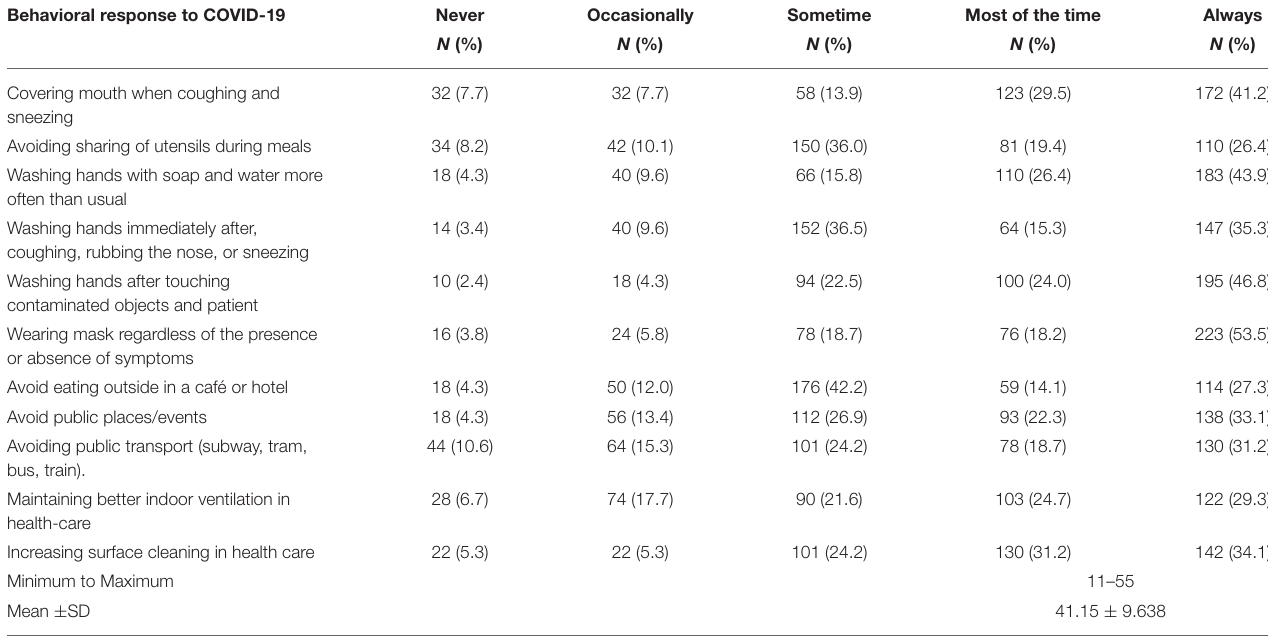
TABLE 3 | Early behavioral response of HCWs to COVID-19 pandemic in North Shoa Zone health care facilities, Oromiya region, July 2020 ( n = 417). Behavioral response to COVID-19 Never Occasionally Sometime Most of the time